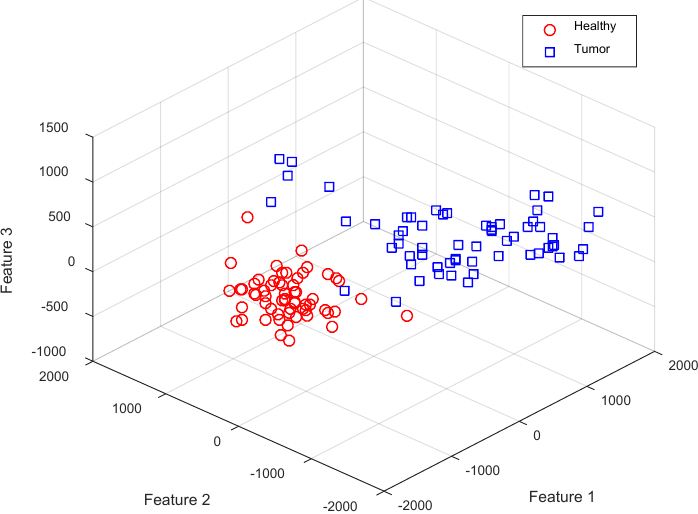
Figure 6. The distribution of samples belonging to each target class based on 3 features extracted by the SVD algorithm in BRATS2014 .